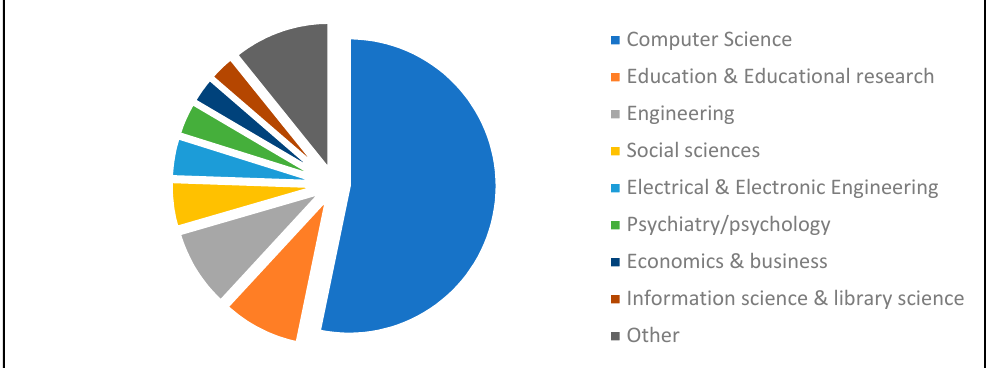
Figure 6. Pie chart of the Distribution of Fields of